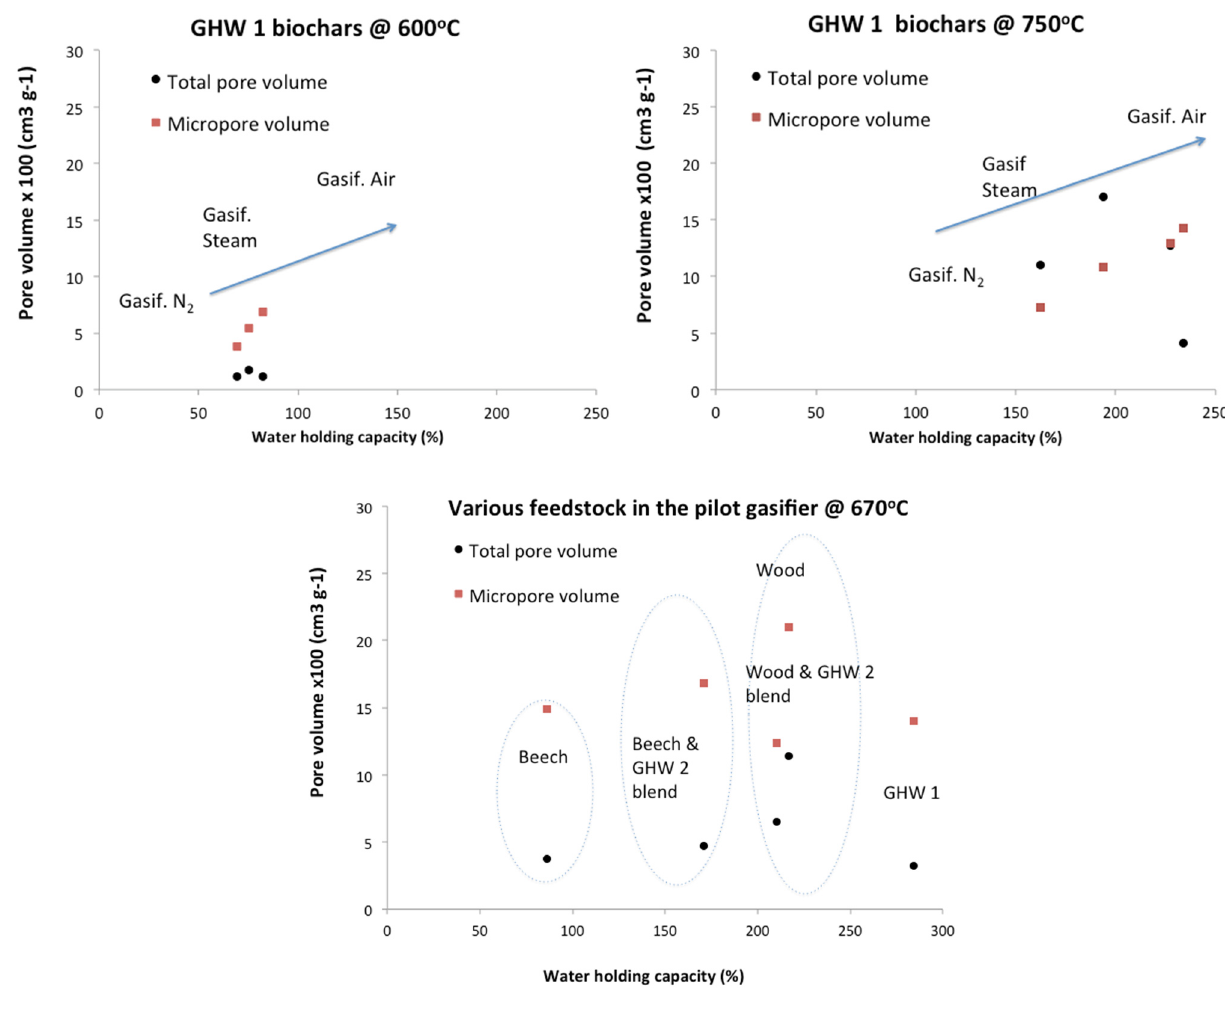
Figure 12. Water holding capacity related to the total and micropore volume for the obtained greenhouse waste (pepper) biochar samples ( a ) at 600 °C and ( b ) 750 °C and ( c ) for all larger scale gasification biochar samples at 670 °C.